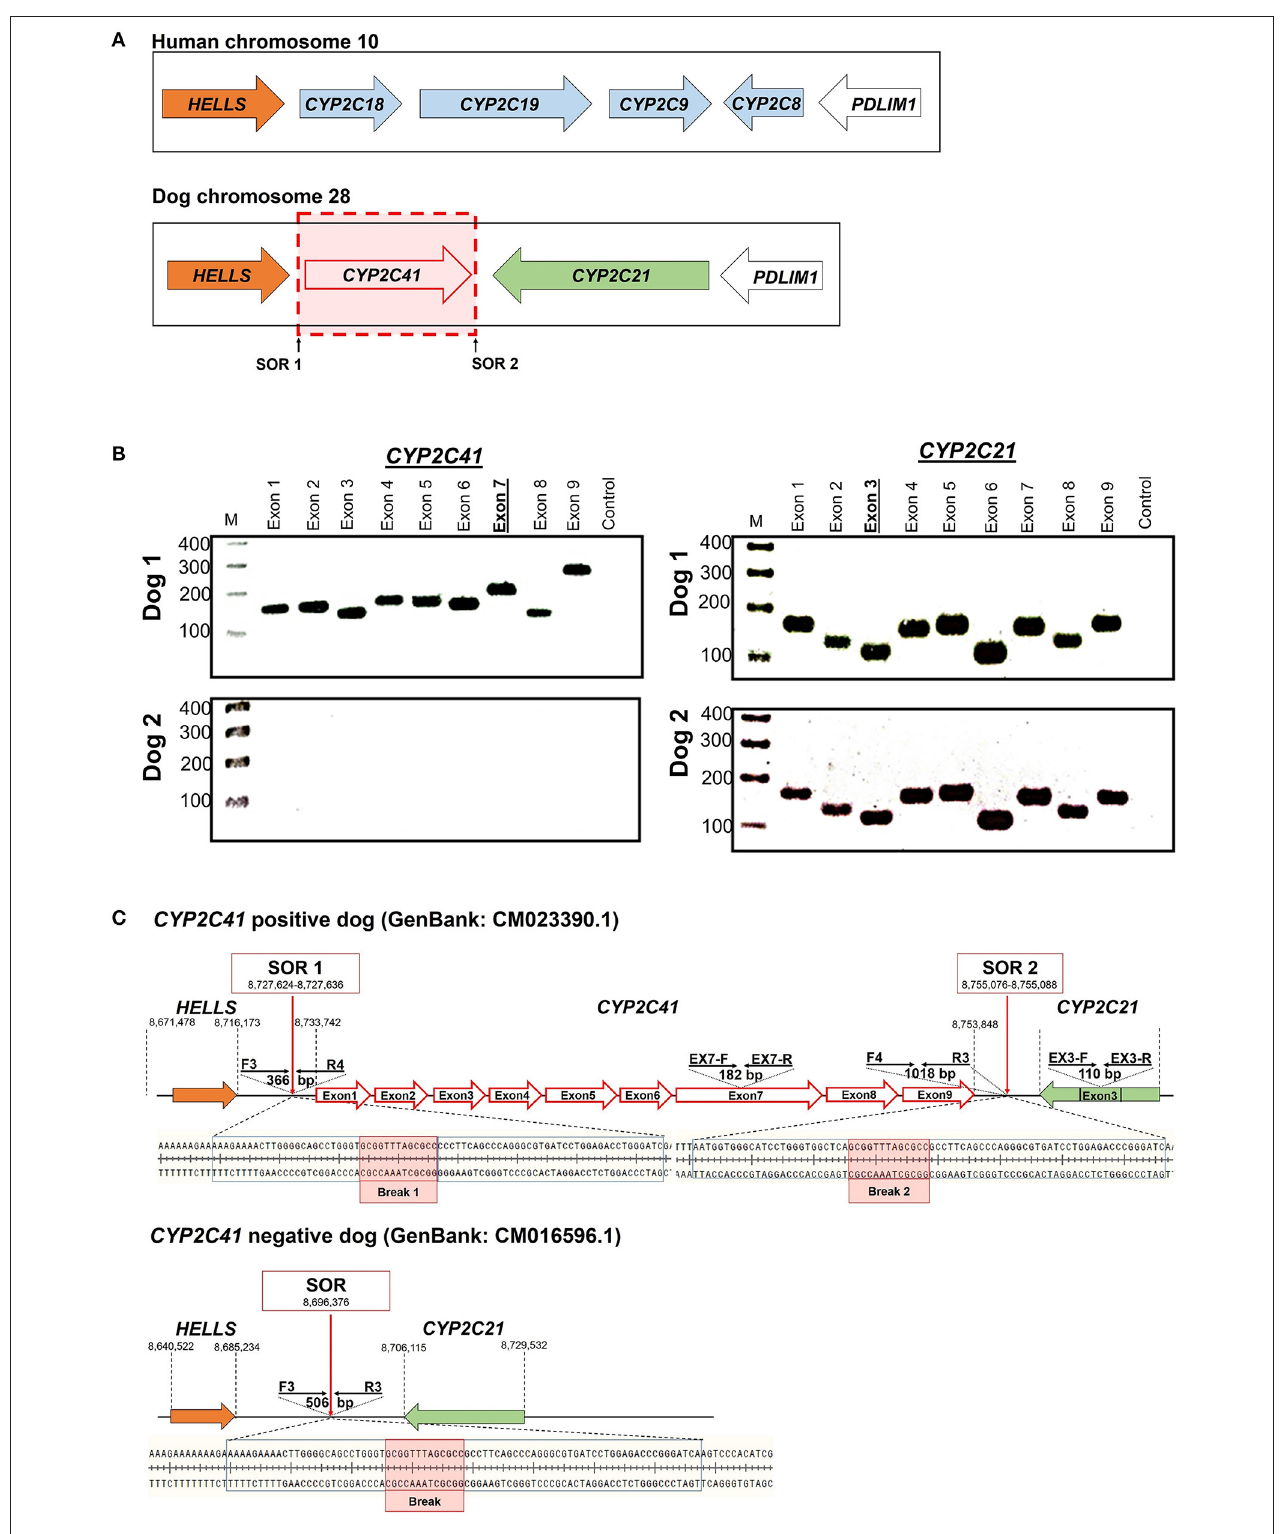
FIGURE 1 | Genomic CYP2C41 gene deletion polymorphism. (A) Chromosomal localization and organization of human and canine CYP2C gene clusters on chromosomes 10 and 28, respectively. Gene arrangements with corresponding proportions derived from the NCBI Genome Data Viewer